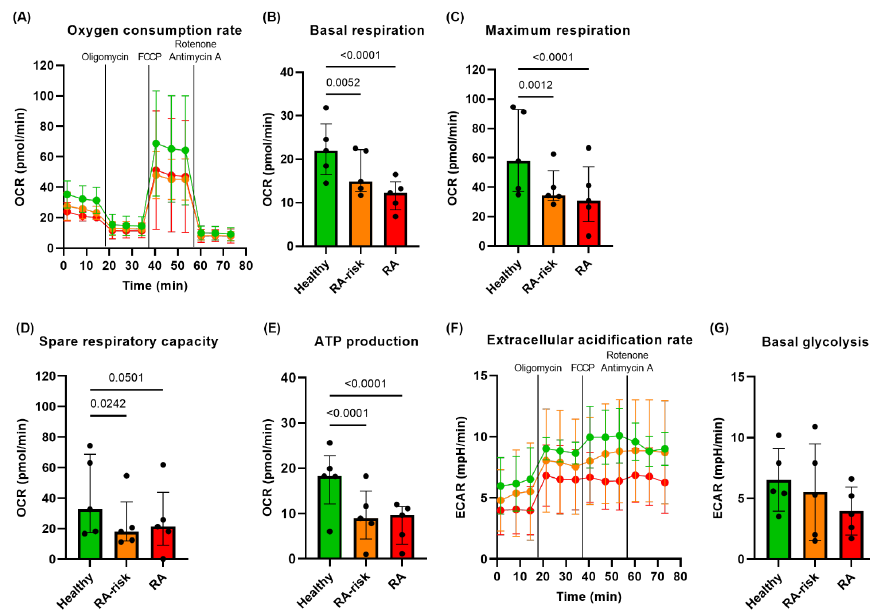
Figure 1. Lower basal and maximum mitochondrial respiration in RA LNSCs compared with healthy LNSCs. ( A ) Real-time oxygen consumption rates (OCR) indicating the mitochondrial respiration rate of cultured LNSCs. Basal OCR and extracellular acidification rate (ECAR) measurements were performed before ATP synthase was inhibited using oligomycin to measure the mitochondrial ATP production. After challenging LNSCs with FCCP, maximum mitochondrial respiration and spare respiratory capacity were measured. The addition of rotenone and antimycin A allowed for the estimation of non-mitochondrial respiration rates. ( B ) Basal mitochondrial respiration. ( C ) Maximum mitochondrial respiration. ( D ) spare respiratory capacity. ( E ) ATP production. ( F ) Real-time ECAR indicating the rate of glycolysis of cultured LNSCs. ( G ) Basal ECAR. All donors passage 4, unstimulated conditions. N = 5 per group and five technical replicates per condition, mean value of five replicates per donor is displayed. Data are normalized according to cell input and presented as median + interquartile range. Statistical differences were determined using two-way ANOVA + Dunnett’s T3 multiple comparisons test.